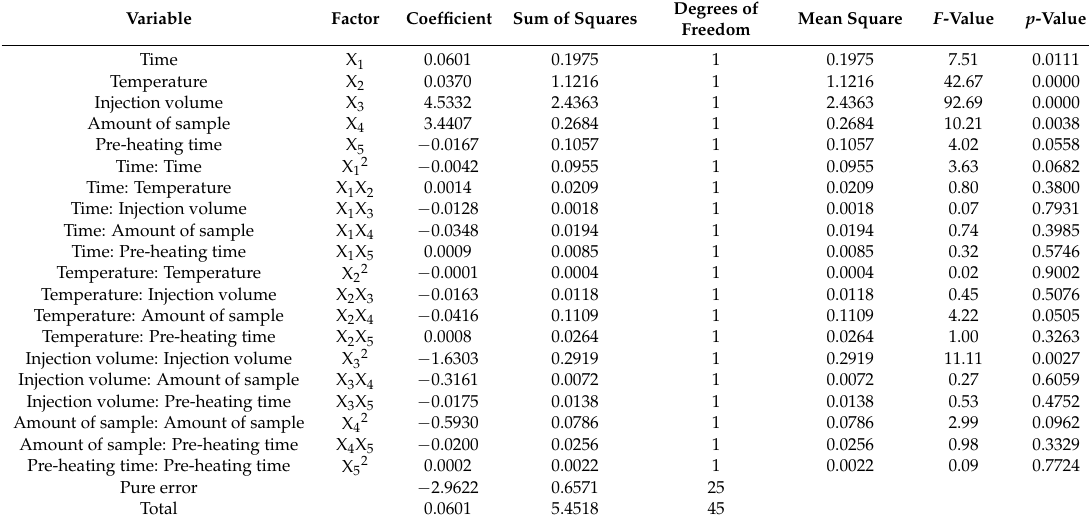
Table 2. Analysis of variance of the quadratic model adjusted to the discrimination of pure honey and HFCS samples.